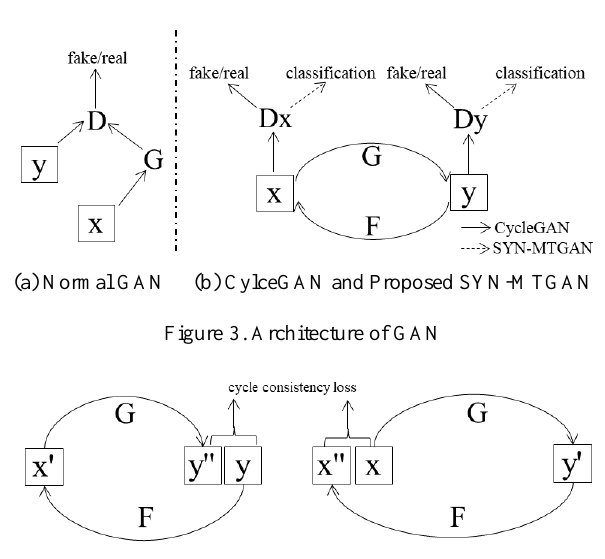
Figure 4. Flowchart of the Cycle Consistent Training